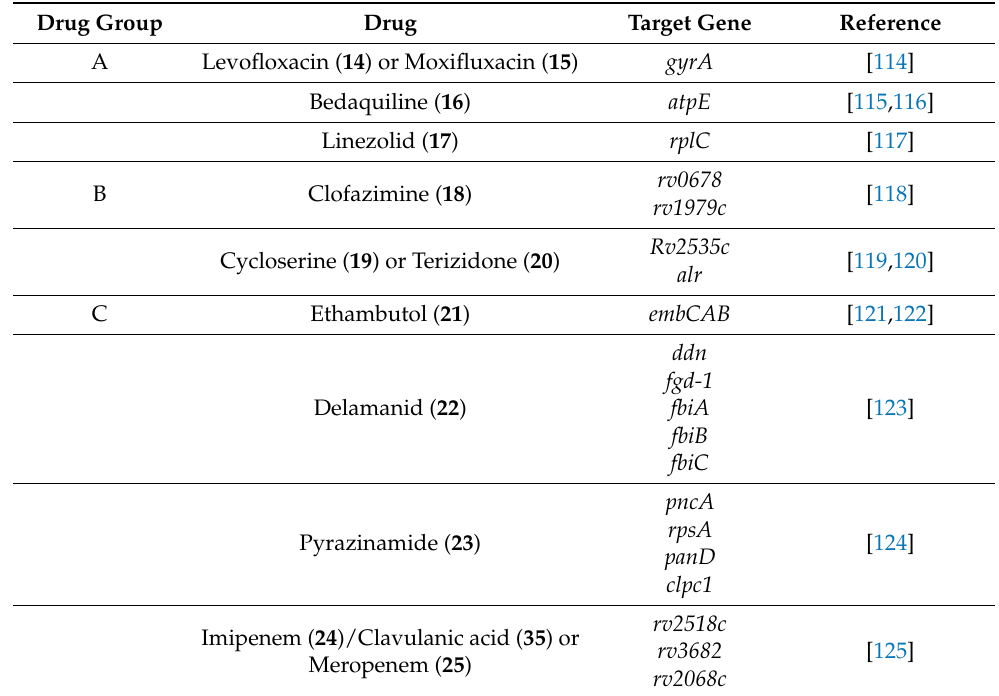
Table 3. The major target genes that confer resistance in the treatment of tuberculosis in cases of mutations. Drug